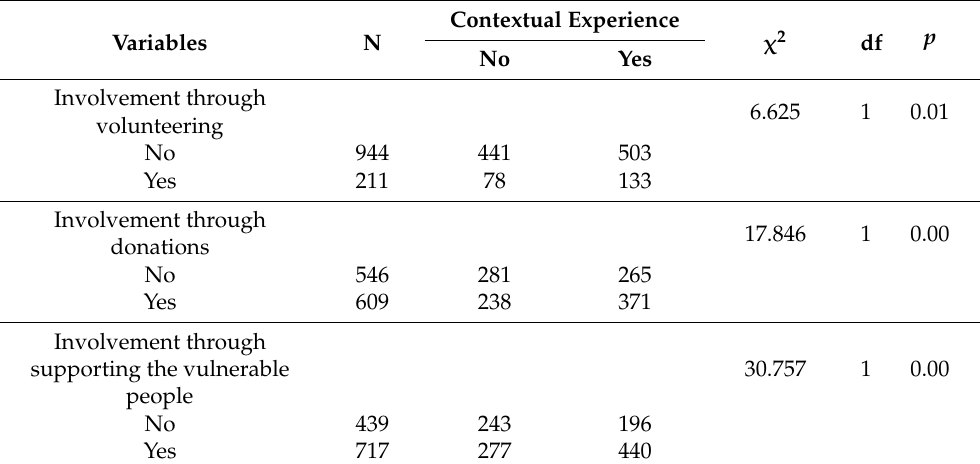
Table 2. Table of associations: Personal involvement in the fight against COVID-19—contextual experience/distance from the